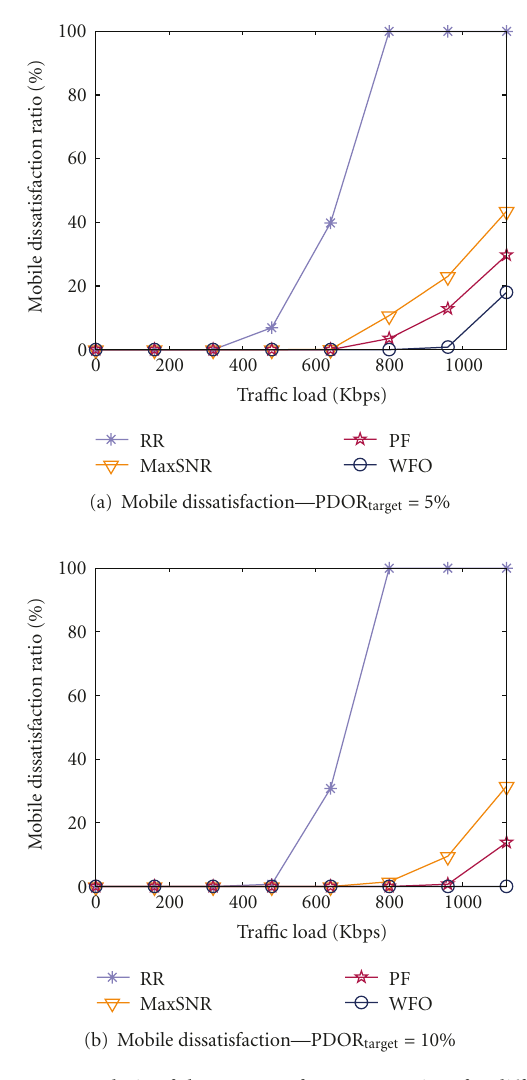
Figure 10: Analysis of the respect of QoS constraints for di ff erent targeted